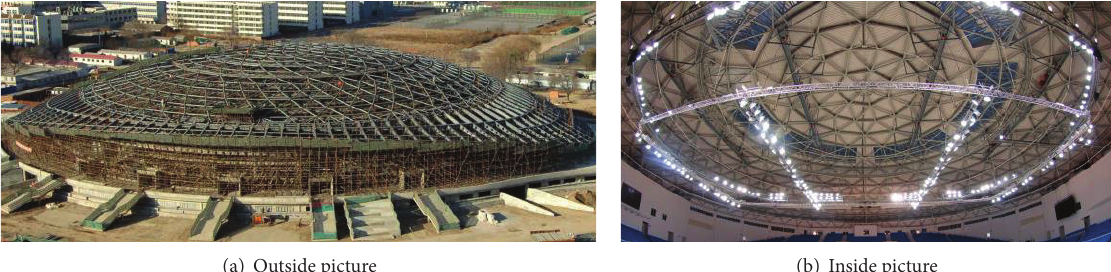
Figure 14: Suspended dome structure project.